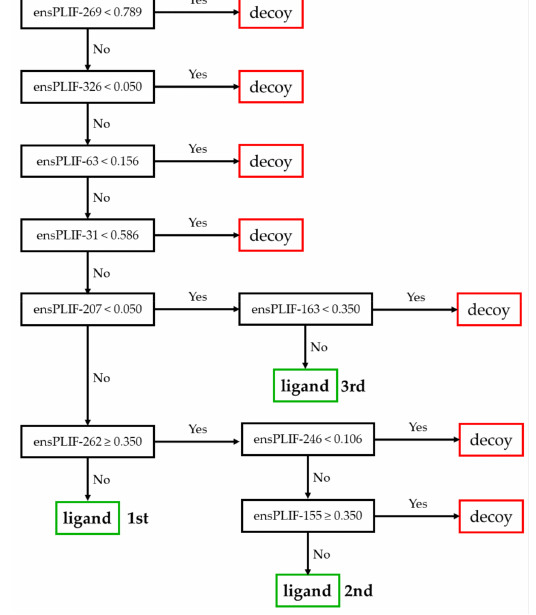
Figure 2. The best decision tree to identify ligand for ADRB2.